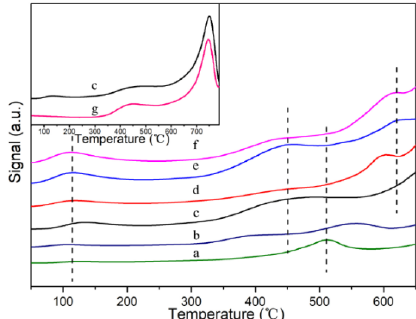
Figure 5. CO 2 -TPD profiles of: (a) CoO x /NC-600 calcined from ZIF-67; (b) CoZnO x /NC-600 calcined from the mechanical mixture of ZIF-67 and ZIF-8 (1:1); (c) ZnO/NC-600; (d) ZnCo 0.8 /NC-600; (e) ZnCo/NC-600; (f) ZnCo 1.2 /NC-600; (g) ZnO/NC-600 without CO 2 adsorption.